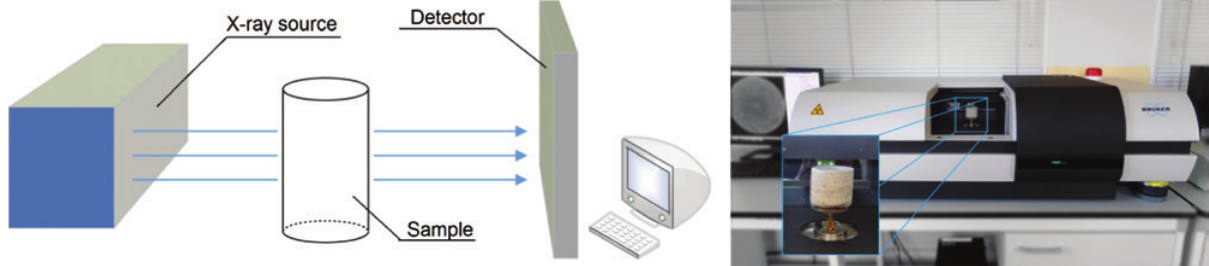
Figure 3: The construction of the microCT